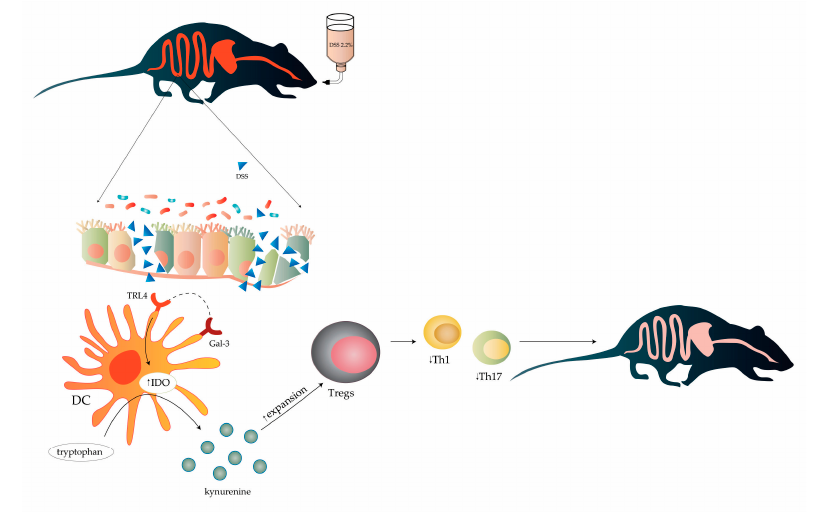
Figure 10. Scheme of Gal-3-dependent modulation of chronic DSS-induced colitis. The main mechanism by which Gal-3 regulates immunosuppressive capacity of regulatory DCs in the gut is relied on the TLR-4-dependent activation of IDO-1 / KYN pathway and consequent expansion of colon-infiltrated Tregs, which suppress Th1 and Th17 cell-driven colon inflammation.